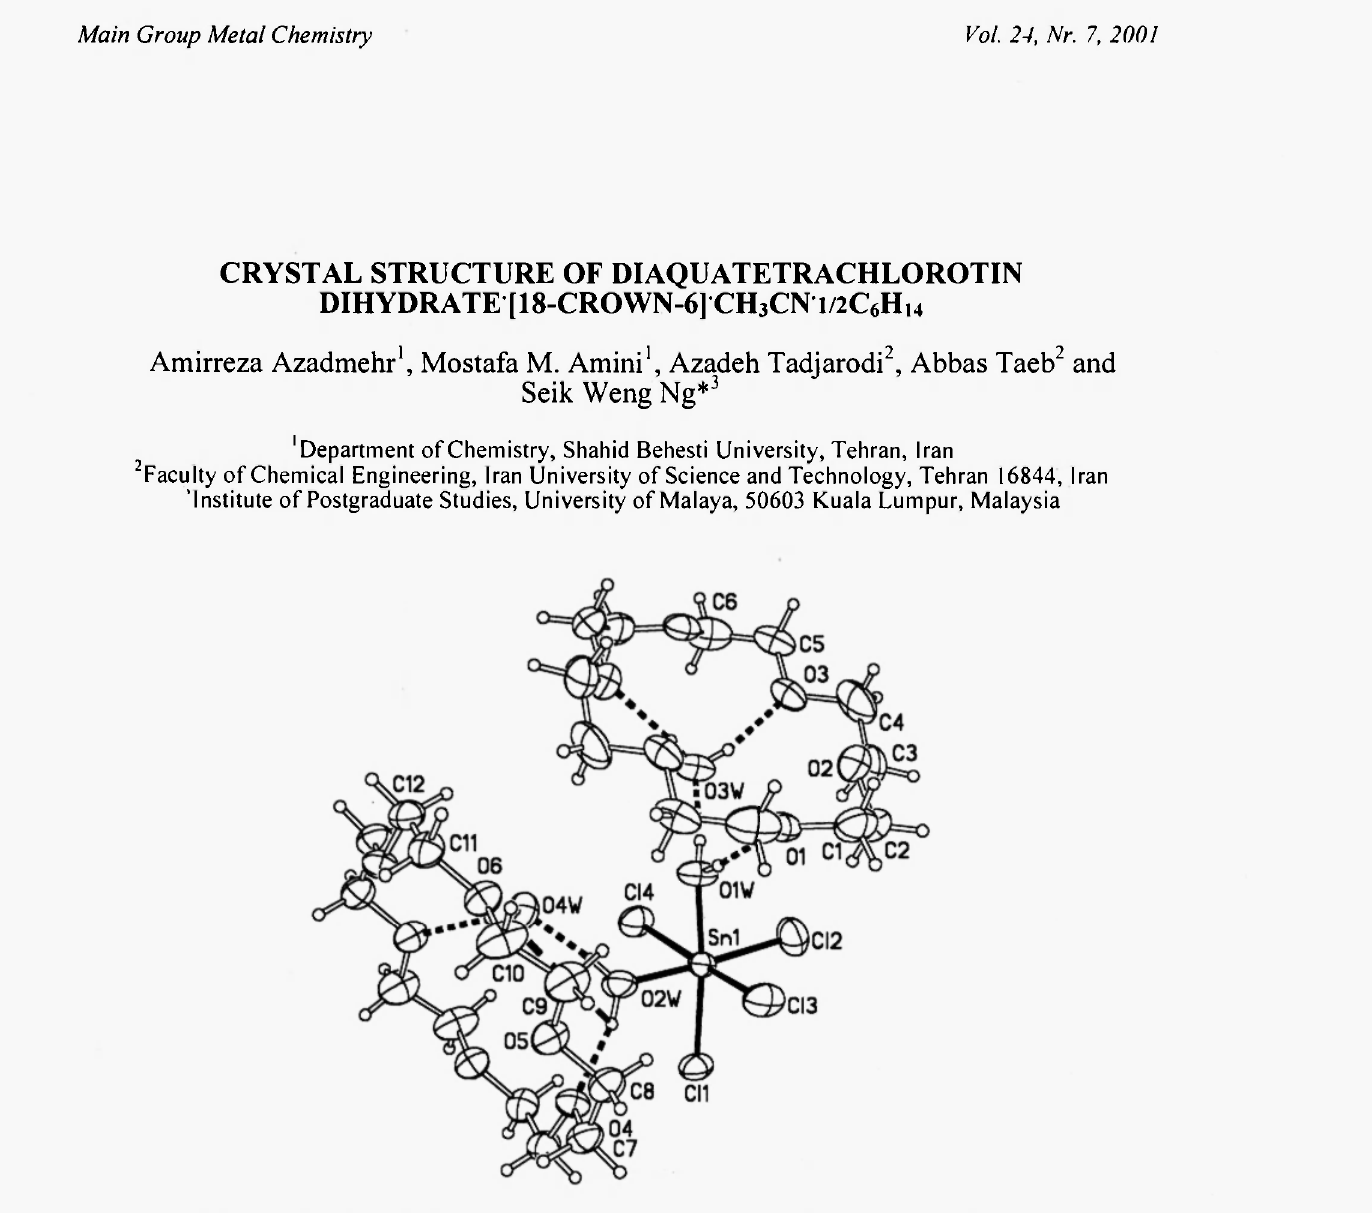
Figure I. 50% Probability ORTEP plot illustrating the geometry of the tin atom in the title compound. The acetonitrile and hexane molecules are not shown. Selected bond distances and angles: S n l - O hv 2.1 19(3), Sn 1 -02w 2.107(3), Snl-Cll 2.378(1), Snl-CI2 2.381(1), Snl-CI3 2.389(1), Snl-CI4 2.374(1) A; 0 1 w - S n l - 0